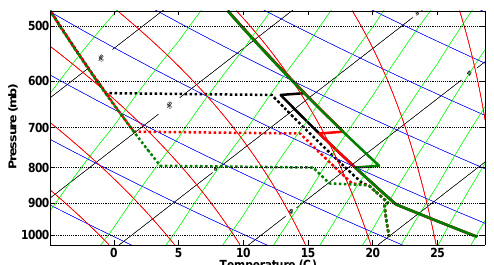
Figure 1. Thermodynamic diagram presenting examples of three of the initial atmospheric profiles; T1RH1 (black), T2RH2 (red), and T3RH3 (green). Solid lines denote temperature profiles and dashed lines dew-point temperature. In total, we ran simulations for nine different initialization profiles.